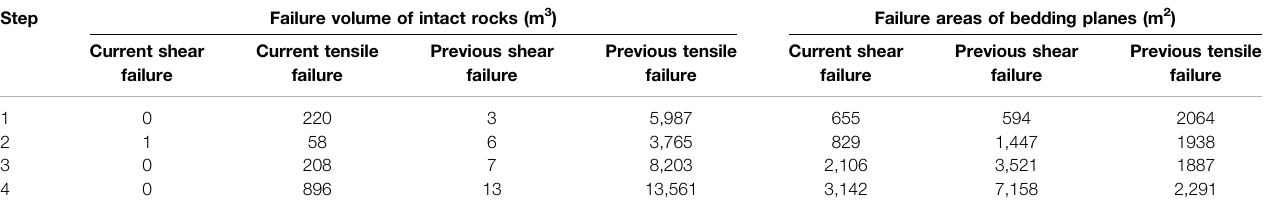
TABLE 6 | Summary of the rock mass failure indices under nonsupported conditions.